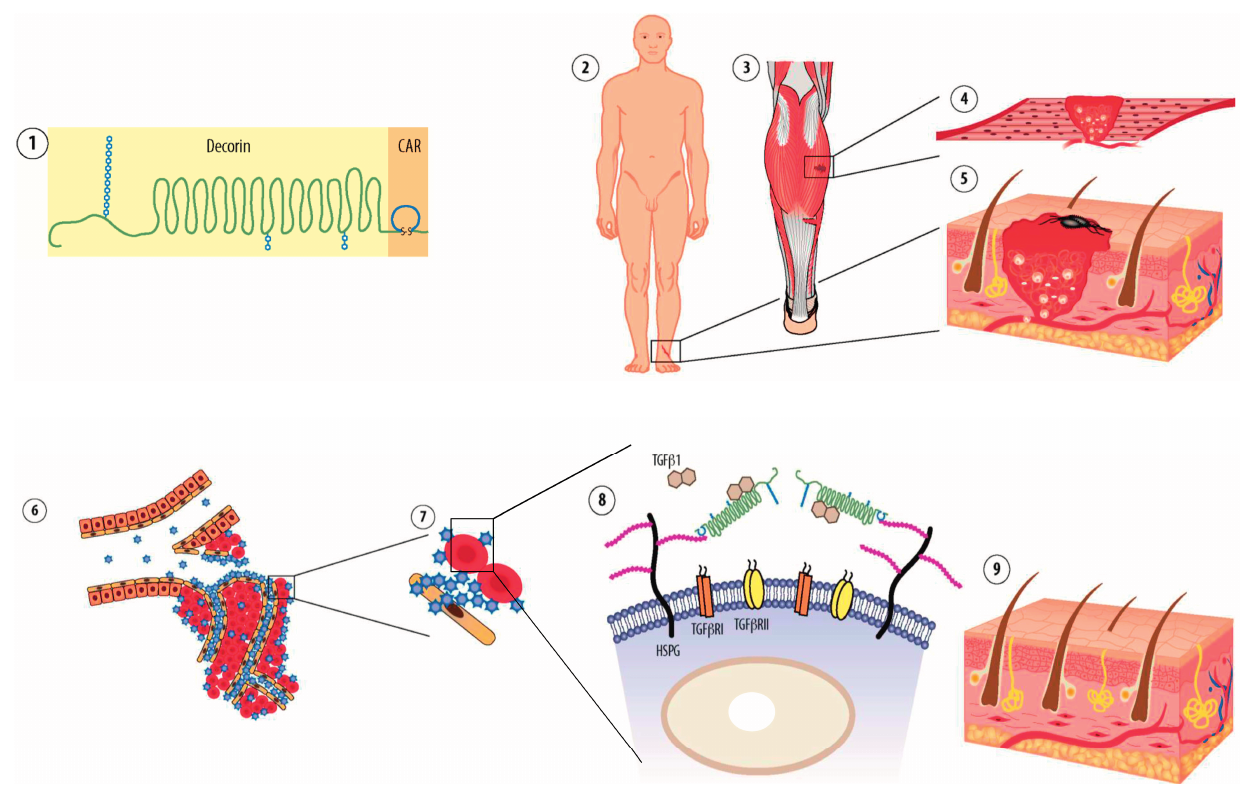
Figure 5. Schematic representation of the mechanism of action of the systemically administered, target organ-specific anti-fibrotic molecule, CAR-decorin. CAR-decorin ( 1 ) is a systemically administered, target-seeking, multi-functional biotherapeutic that inhibits scar formation. The molecule can be targeted to injury taking place at any organ of the body ( 2 , 3 ) (or multiple organs simultaneously). The CAR homing peptide targets angiogenic vasculature, which forms at the site of the injury ( 4 , 5 ). The peptide (and any payload attached to it; blue stars) then extravasates into surrounding tissue ( 6 ), where it binds to its receptor(s) on the cell surface of the scar producing fibroblasts ( 7 ). CAR binding to heparan sulfate proteoglycans (HSPGs) provides docking sites in the proximity of the main scar-inducing growth factors TGF- β 1 and TGF- β 2 ( 8 ) facilitating the neutralization of these growth factors by the therapeutic part of the molecule, decorin ( 8 ). This mechanism results in therapeutic response ( 9 ) seen as reduced scar formation in the skin [39]. Picture by Helena Schmidt; reproduced after modification with permission from [57], Copyright 2011 Finnish Medical Journal